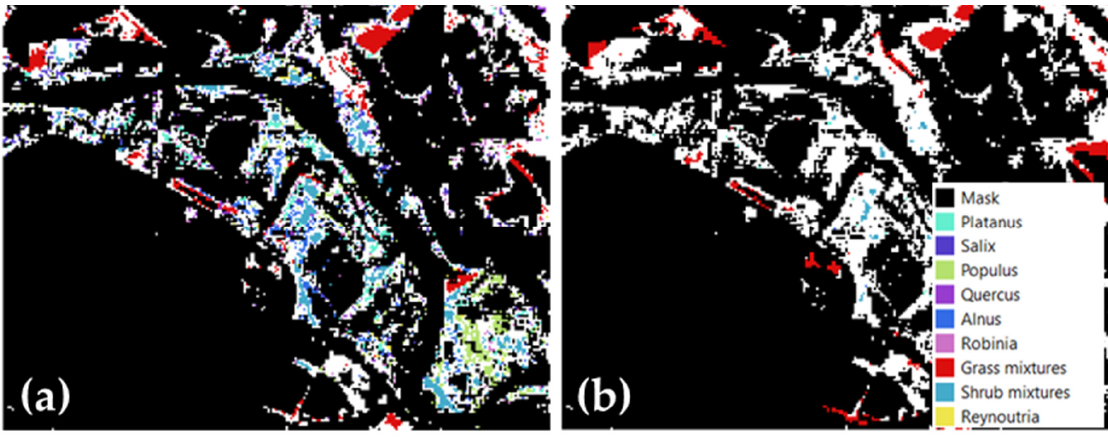
Figure 14. Illustration of the rejection class (in white) with ( a ) RLR-ℓ1 and ( b ) RF classification maps.